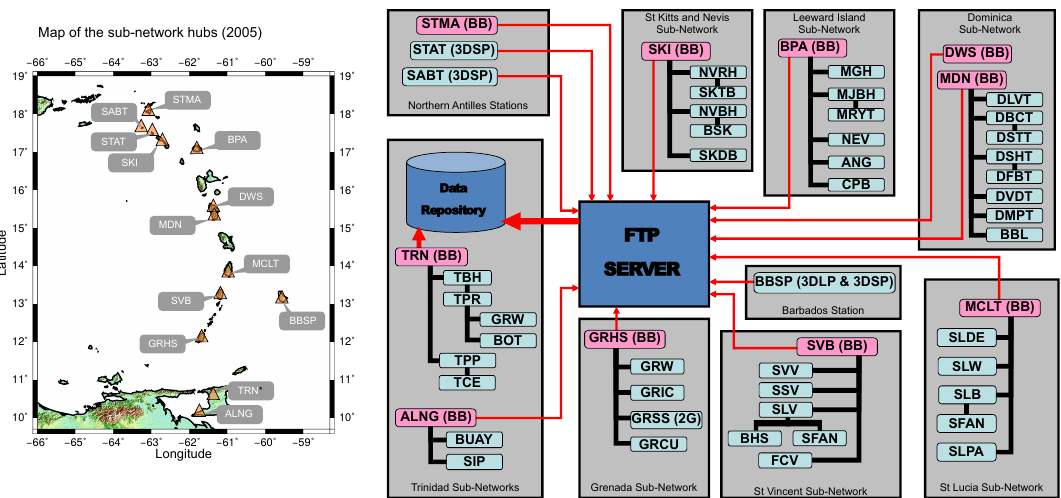
Figure 7. ( Left ) The 2005 Seismic Research Unit (SRU) sub-network nodes and their location in the Eastern Caribbean; ( Right ) Sub-network nodes (pink rounded rectangles) as part of the hybrid SRU’s seismic network. 3DSP: 3-component short period instrument; 3DLP: 3-component long period instrument; BB: Broadband instrument; Light green color refers to a foreign short period instrument shared with SRC’s